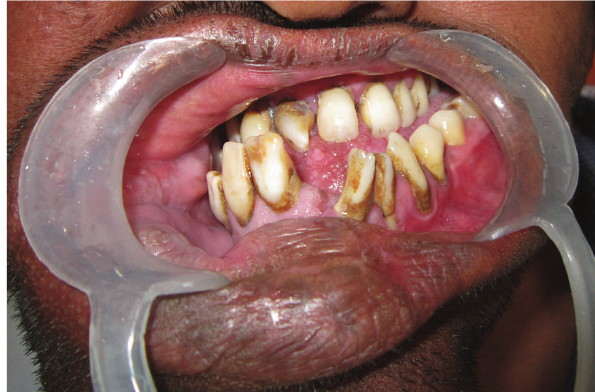
Figure 4: Intraoral photograph showing velvety buccal mucosa hanging in pendulous folds and granular gingival surface along with macrodontic permanent right lateral incisor and canine.